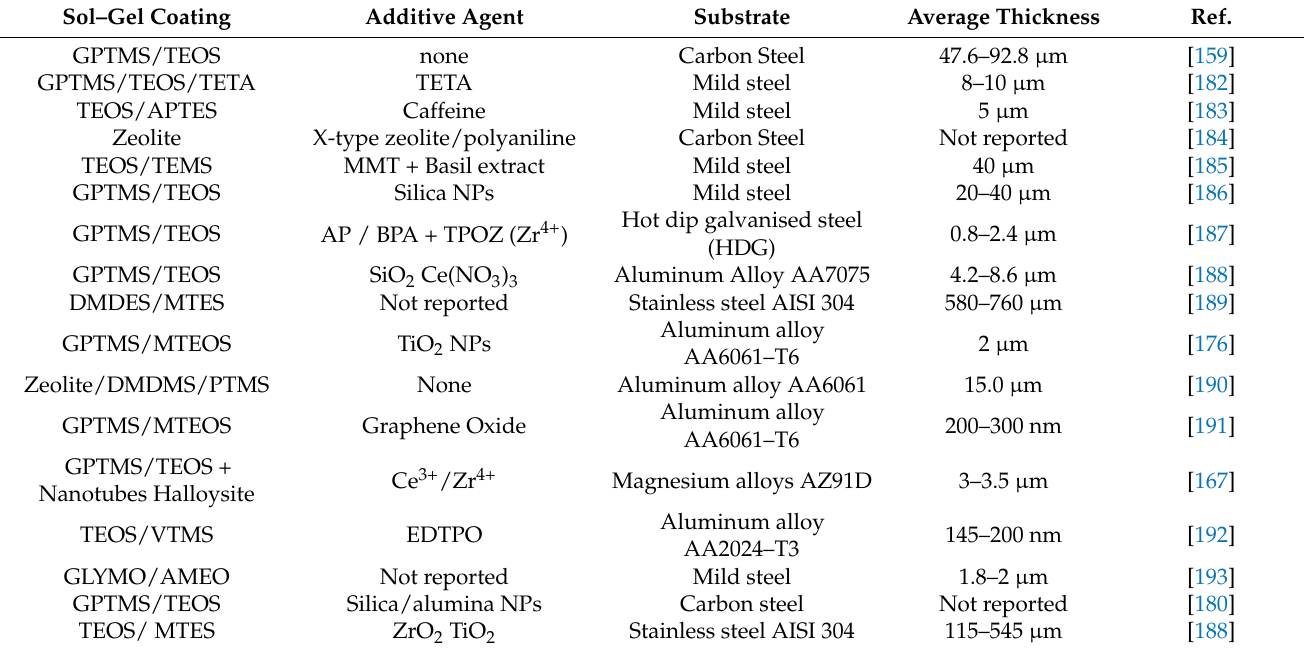
Table 2. Different compositions fabricated on different metallic substrates by sol–gel method in corrosive NaCl media. Sol–Gel Coating Additive Agent Substrate Average